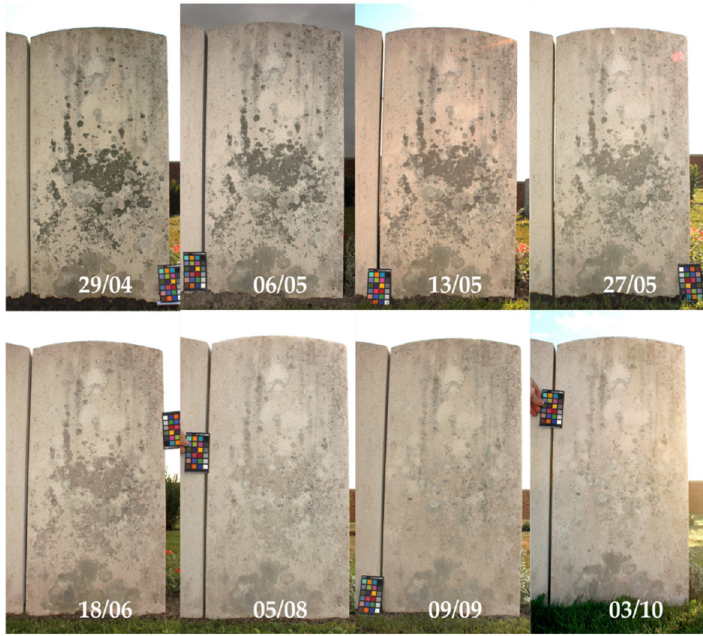
Figure 8. Evolution of grey-black streaks and lichen (Site